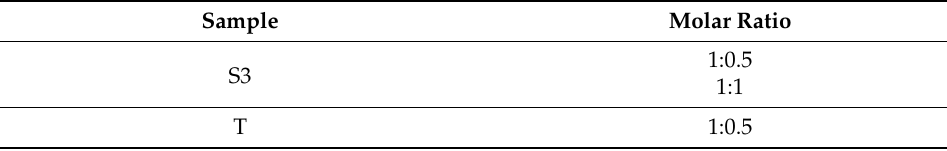
Table 5. Coating ratios between sample and HA-Chol 1mg/mL.